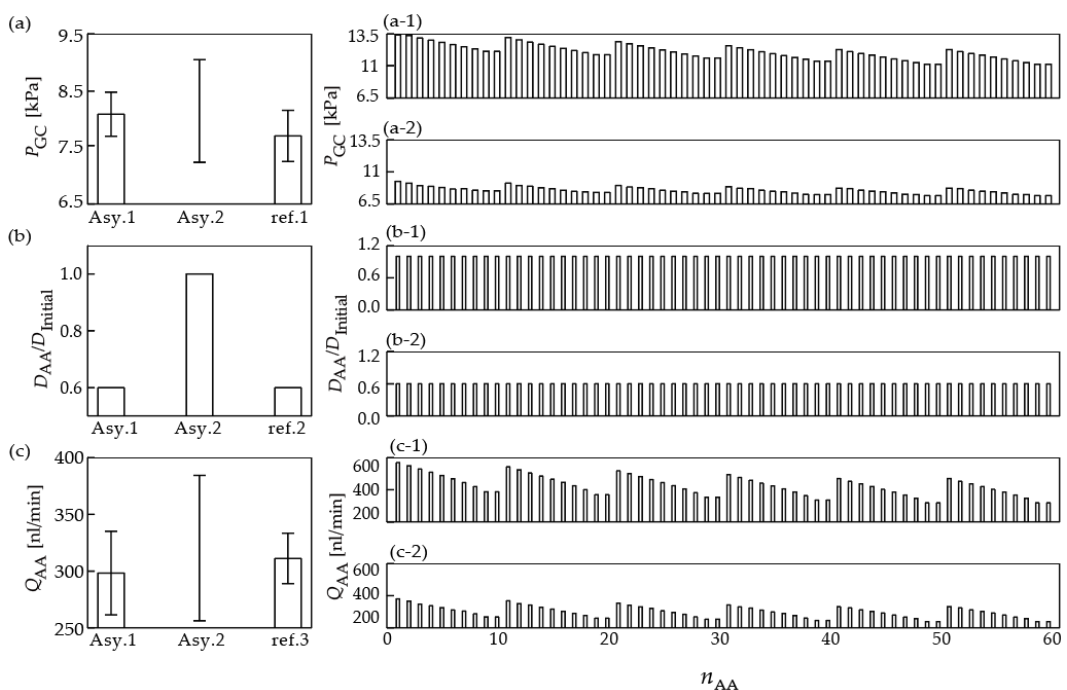
Figure 7. Same as Figure 4 but with 𝑃 inlet = 21 kPa.